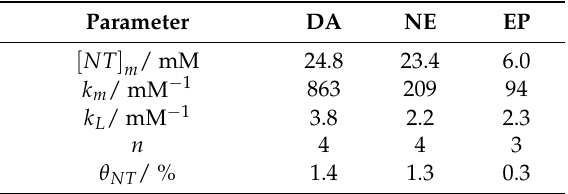
, affinity constant for the formation of a m